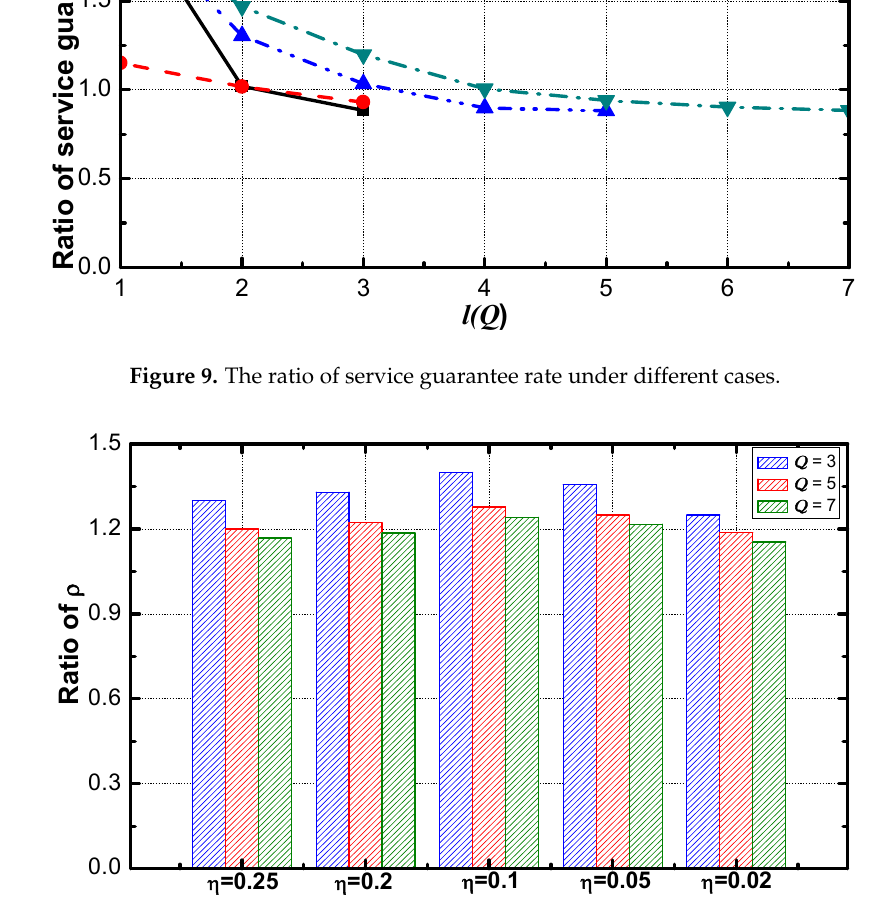
Figure 9. The ratio of service guarantee rate under different cases.